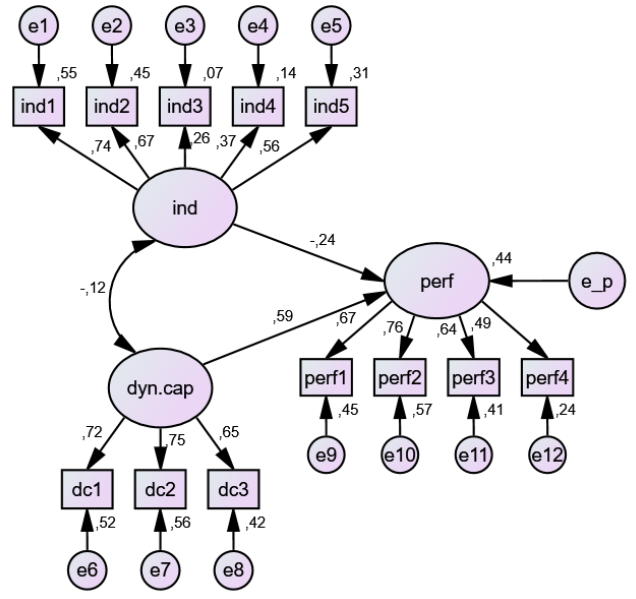
Figure 1. Structural Performance Model—Standardised Estimate.